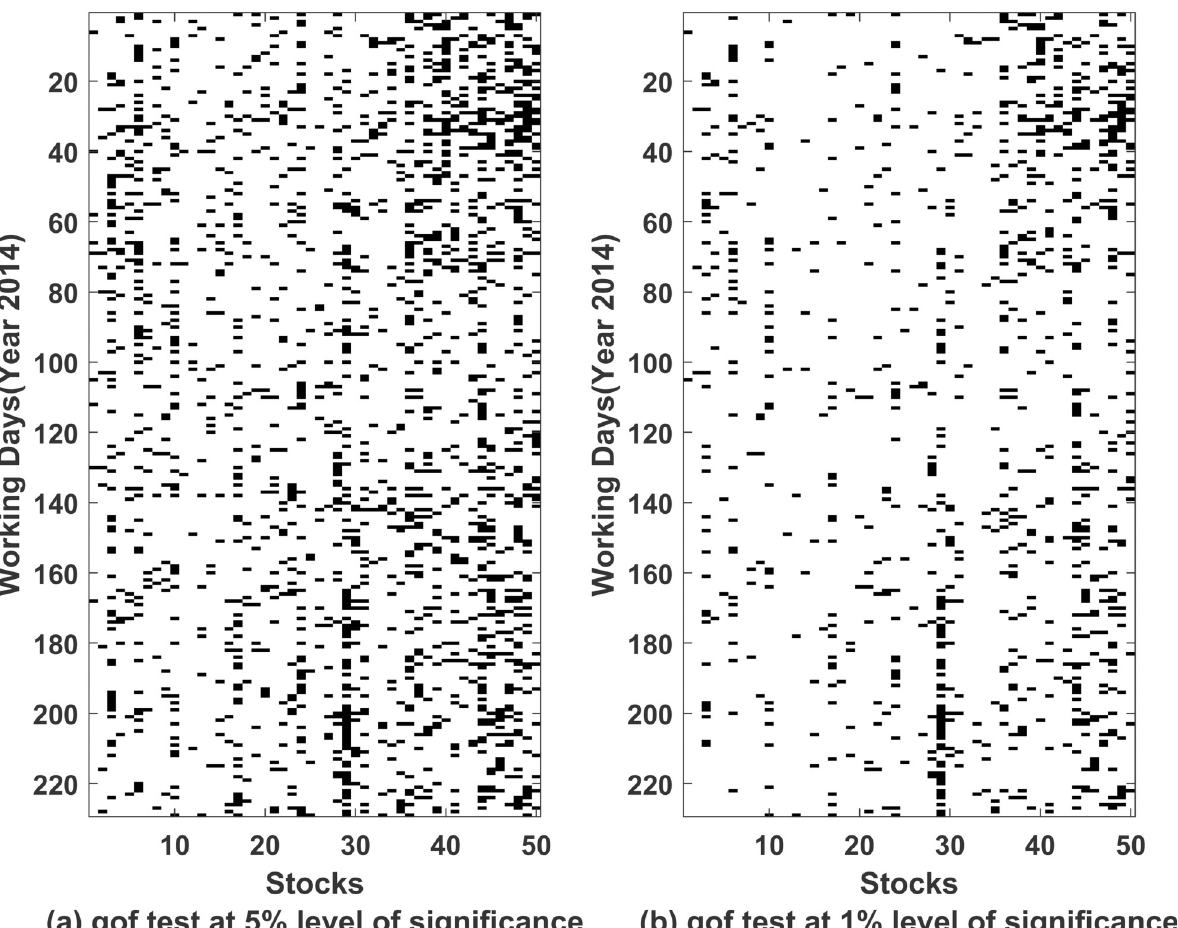
Fig 6. Goodness of fit test for ARMA(1,1)-EGARCH(1,1) model. On horizontal axis we have listed 50 stocks and on vertical axis we have working days of year 2014. Black and white colour represents that the null hypothesis ( H 0 : ARMA (1,1) − EGARCH (1,1) is a good fit) is rejected or accepted respectively. (a) Corresponds to test at 5% level of significance (b) Corresponds to test at 1% level of significance.